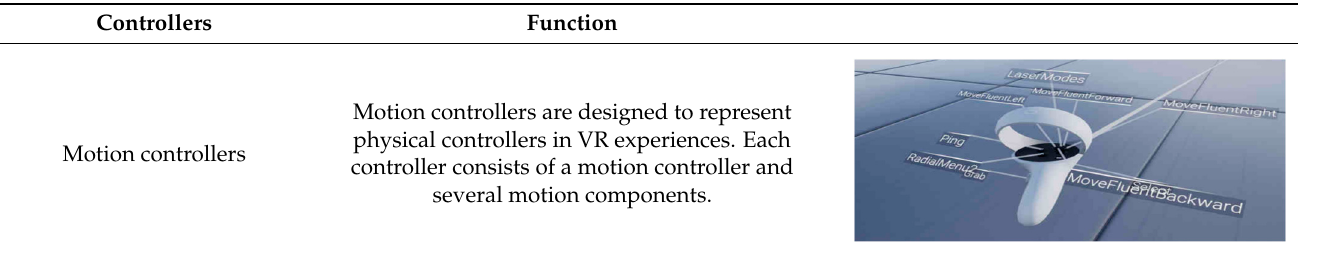
Table 1. Controller styles with functionalities.